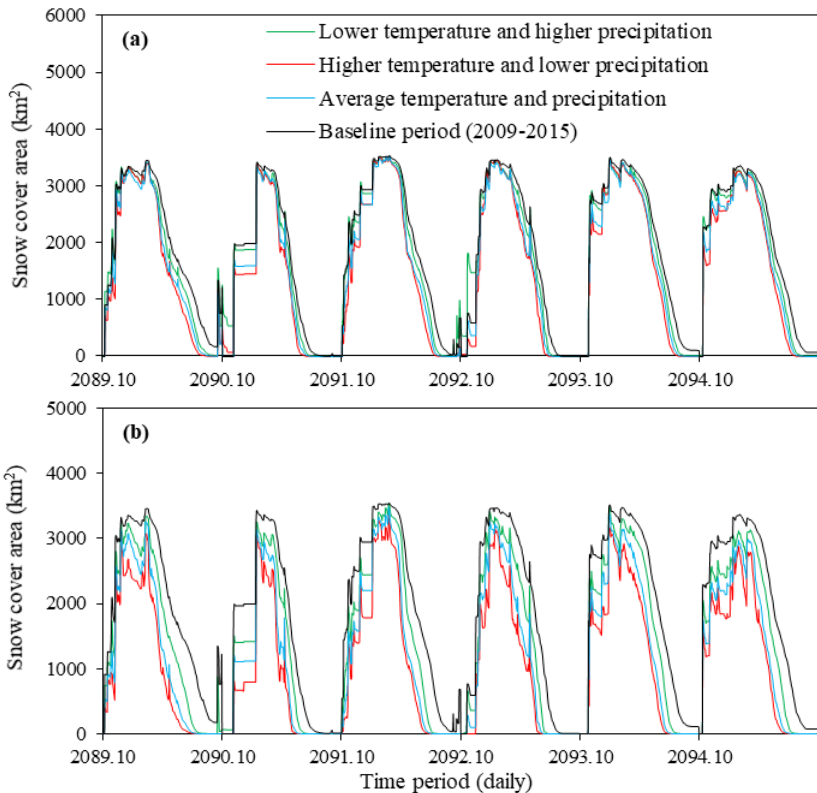
Figure 6. Projected SCA during the mid-21st century (2049–2055) under ( a ) RCP 4.5 and ( b ) RCP 8.5, in average, lower, and higher temperature and precipitation scenarios.